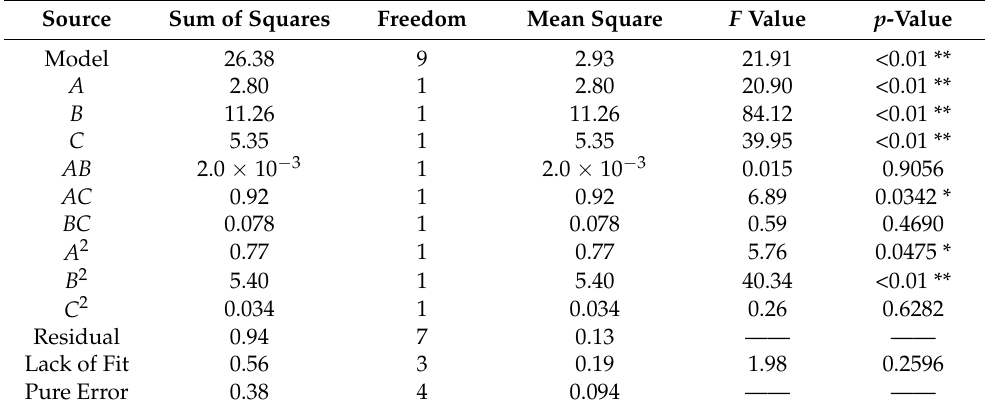
Table 8. Variance analysis of quadratic term model of power